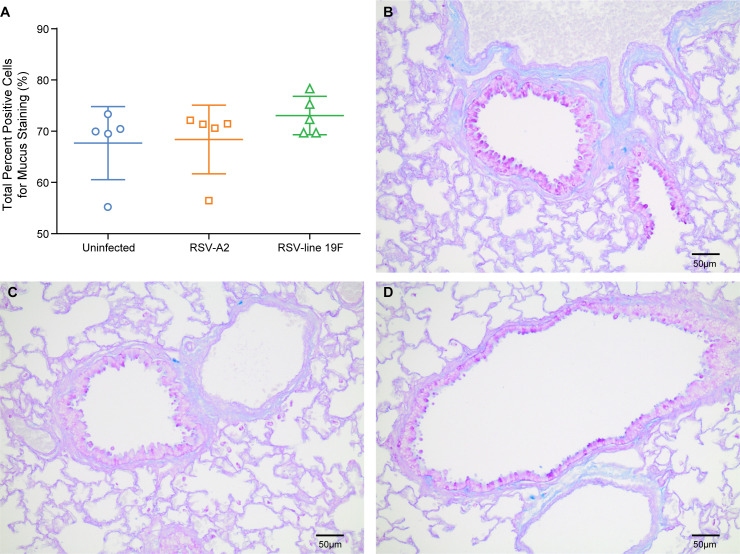
Mucus production in cotton rats 8 days post-infection with RSV A2 and RSV line 19F.2a. Quantification of PAS and Alcian blue positive (mucus) staining in bronchioles was performed using the Color Deconvolution algorithm in Image Analysis Toolbox. Mucus production was assessed at 8dpi based on previous studies in the mouse [8, 16]. The mean total percent positive staining cells and standard deviations are represented (n = 5/ group). Asterisks indicate p value < 0.05 when compared to uninfected cotton rats by One-Way ANOVA. 2b. A representative airway and adjacent alveoli of a PAS/ Alcian blue stained section of uninfected cotton rat lung with little to no mucus production. 2c. A representative airway and adjacent alveoli of a PAS/ Alcian blue stained section of cotton rat lungs 8dpi RSV A2 infection with little to no mucus production. 2d. A representative airway and adjacent alveoli of a PAS/ Alcian blue stained section of cotton rat lungs 8dpi RSV line 19F infection with little to no mucus production.